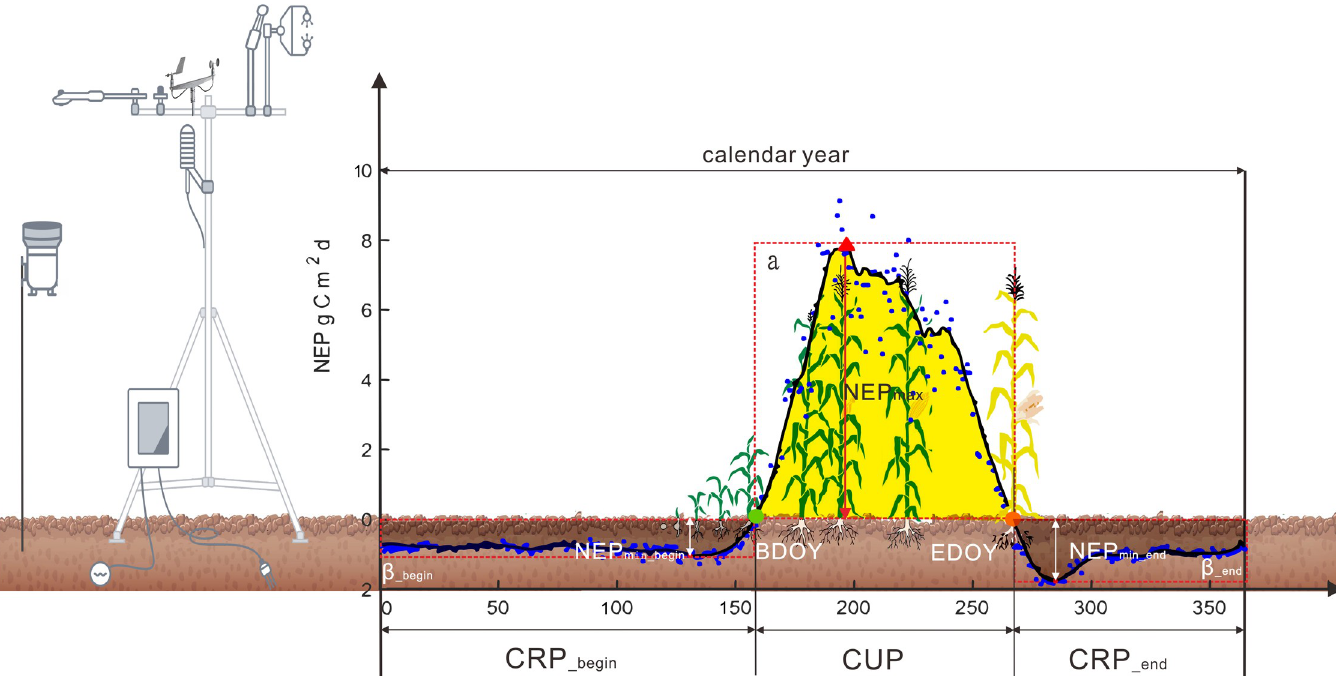
Fig 1. Schematic diagram of variables determining changes in annual net ecosystem CO 2 exchange, including the ratio of actual carbon dioxide uptake to hypothetical maximum carbon dioxide uptake ( α ), maximum daily NEP (NEP max ), carbon dioxide uptake period (CUP), and the ratio of actual carbon release to hypothetical maximum carbon release ( β ), minimum daily NEP (NEP min ) and carbon release period (CRP) at the beginning and at the end of the year. Blue points indicate average daily NEP from 2005 to 2018 in this study; the black line shows 10-day averages.